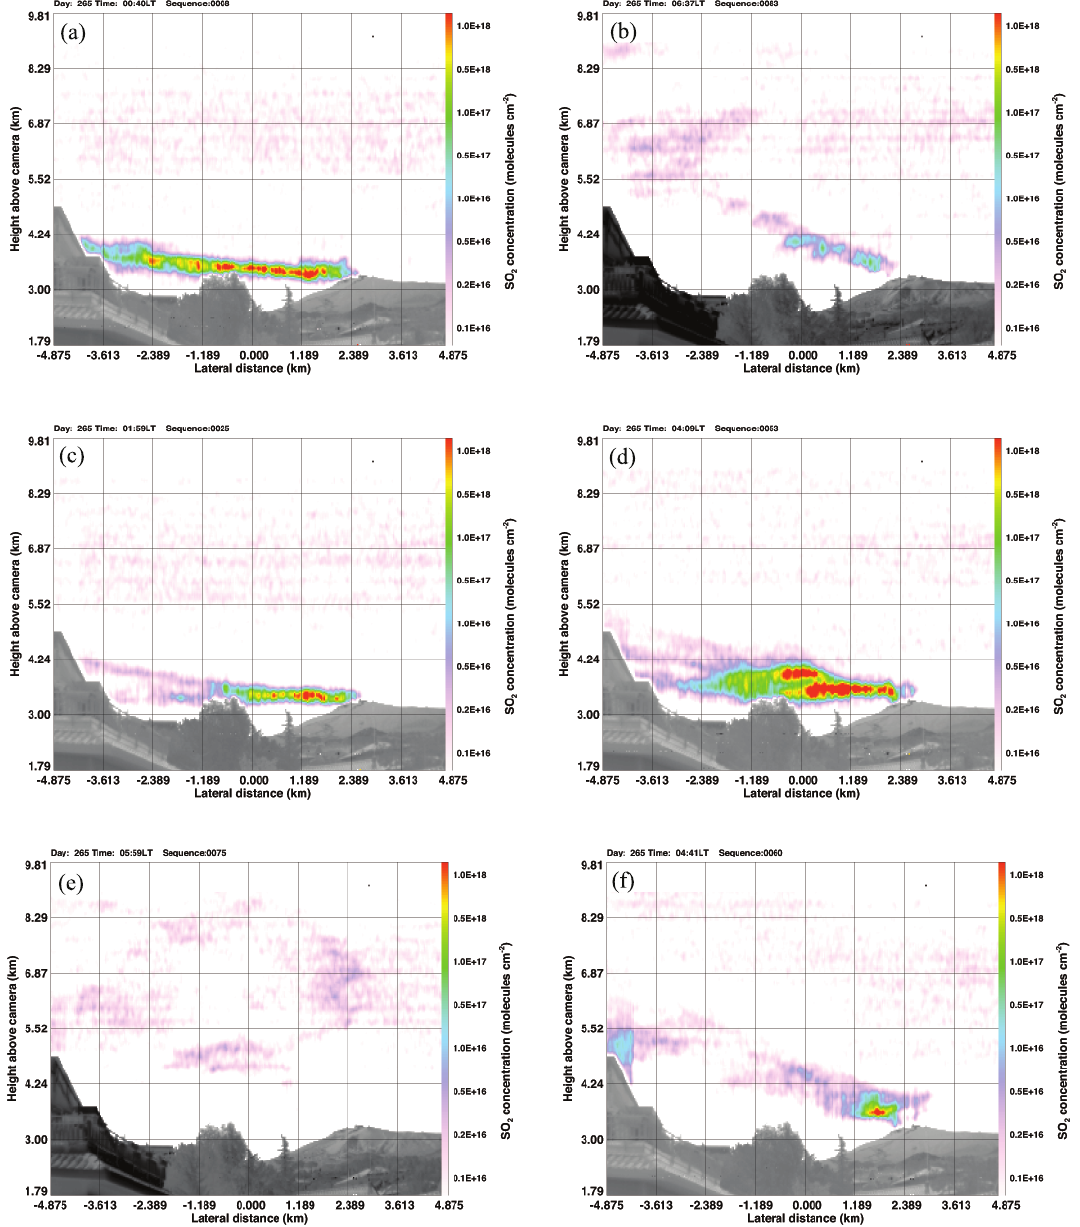
Figure 15. Cyclops viewing a distant ( ∼ 17km) SO 2 plume from Mt Etna, Sicily. The frames illustrate different emission behaviour of the Etna plume. (a) Continuous gas emissions, trapped within the boundary layer; (b) plume rise after the sun has risen; (c) and (d) bifurcation of the plume – it is not possible to tell whether the bifurcating plumes are coplanar or whether one plume is moving away from or towards the camera; (e) reduced activity with little or no gas plume visible; and (f) vigorous gas pulse with an indication of a column and some horizontal dispersion. Note that the apparent high SO 2 SCDs just below 5.52km height and near ∼− 4.9km are probably artefacts due to difficulties in calibrating the images on one part of the focal plane array.